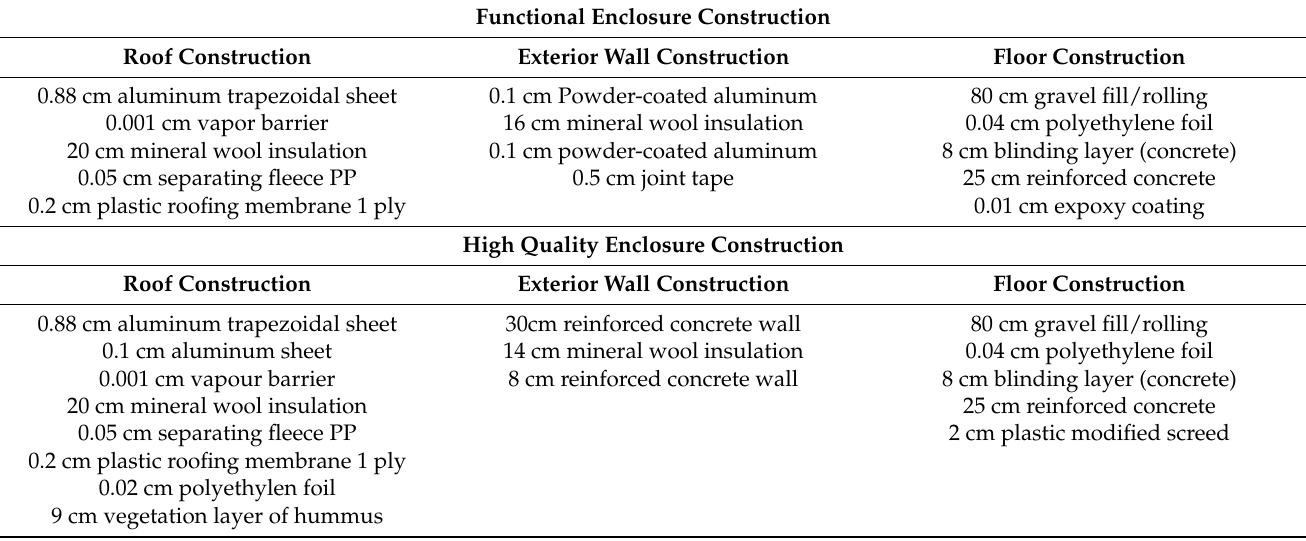
Table 2. Layer of the examined envelope constructions: functional and high quality. Functional Enclosure